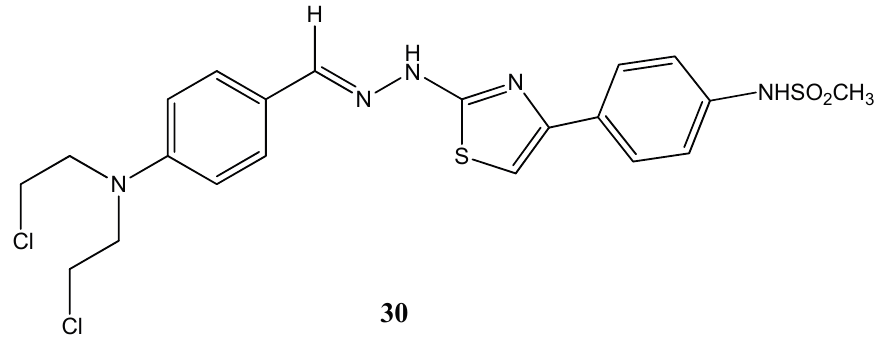
Figure 16. Chemical structure representation of compound ( E )- N -(4-(2-(2-(4-(bis(2- chloroethyl)amino)benzylidene)hydrazinyl)thiazol-4-yl)phenyl)methanesulfonamide ( 8 ) with proven anticancer activity against HCT116 and MCF7 cell lines